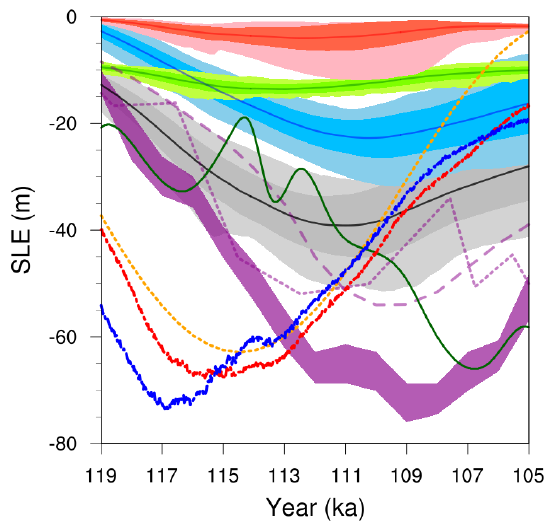
Figure 1. The time evolution of total (black), NA (blue), EA (red), and Greenland (green) ensemble mean ice volumes in metres of sea- level equivalent (SLE) between 119 and 105ka. The dark shading indicates the ± 1 standard deviation range around the mean. The light shading shows the range between minimum and maximum ice volumes in the ensemble. The purple shading and lines (long- dashed and short-dashed) show the respective proxy-based sea-level reconstructions from Lisiecki and Raymo (2005) with 1 σ , Wael- broeck et al. (2002), and Siddall et al. (2003). To make the sea-level reconstructions commensurate with the ice volumes, the present- day ice volume of Greenland has been added to them. The orange and dark green lines depicts the timing of insolation changes at 60 ◦ N and p CO 2 , respectively. The JJA ensemble mean tempera- tures over 50–65 ◦ N of NA and 60–75 ◦ N of EA are shown as thick- dotted blue and red lines,